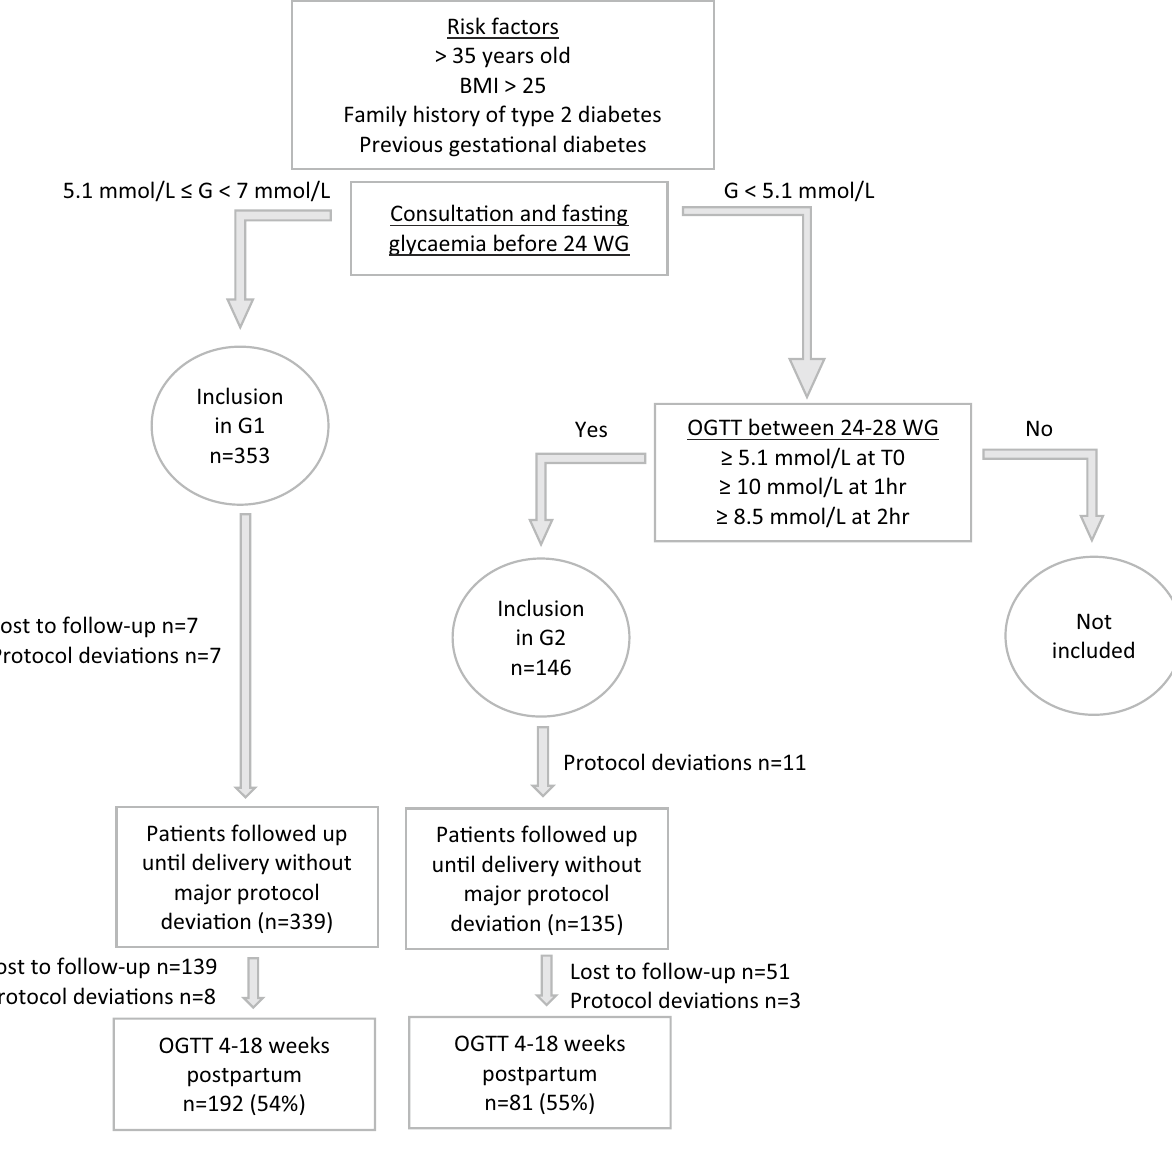
Figure 1. Flow chart. OGTT: oral glucose tolerance test, G: